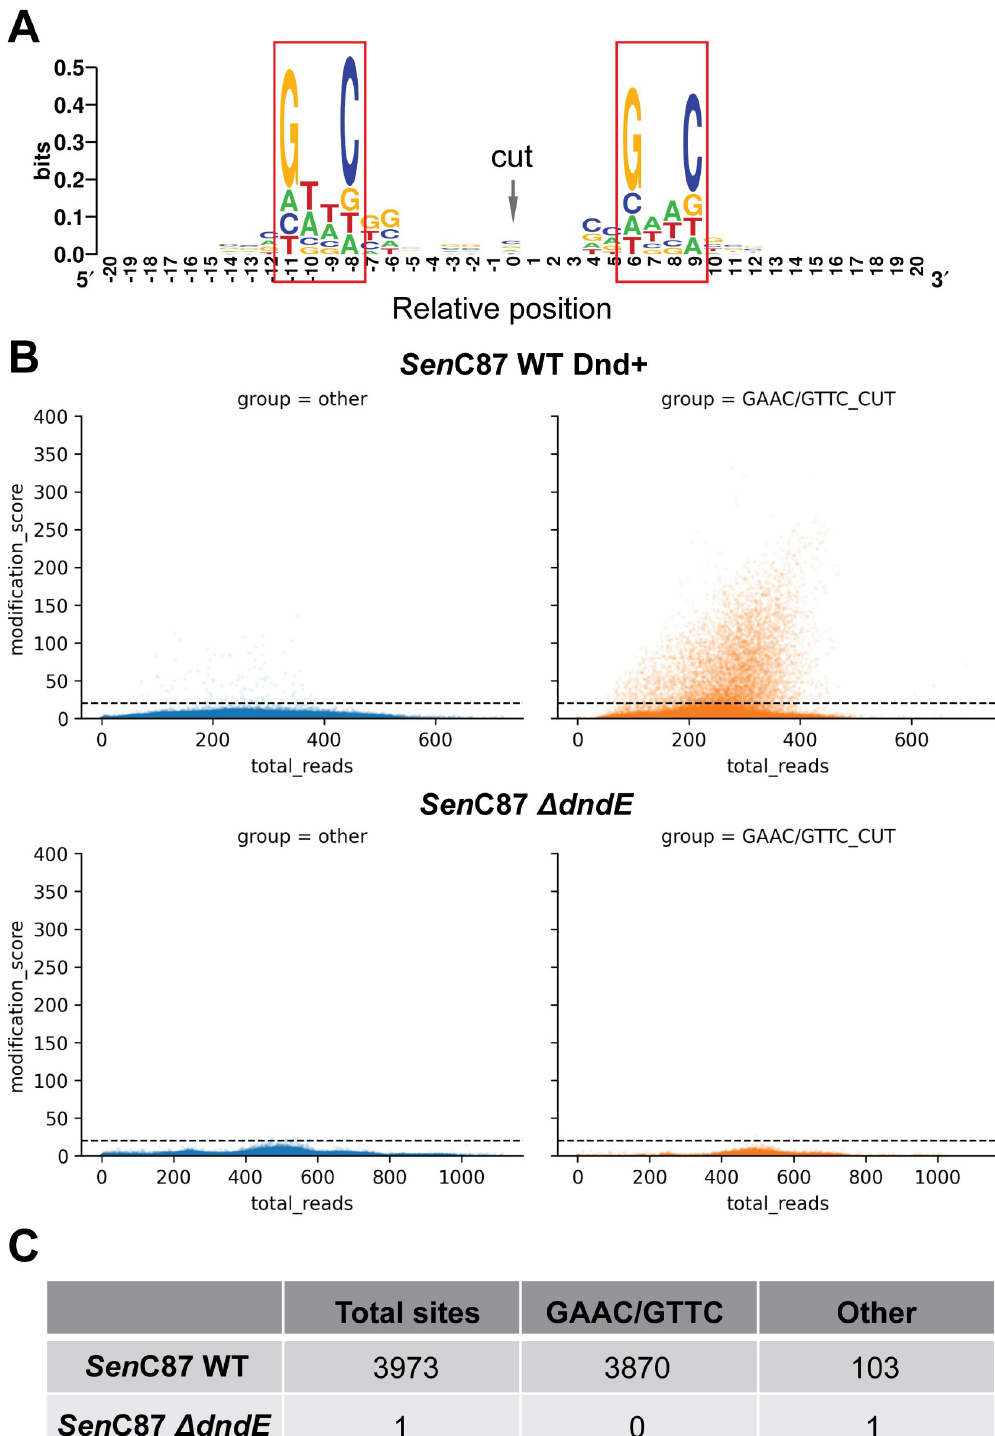
Fig 2. Genomic mapping of PT modification at single base resolution by EcoWI-seq. ( A ) Motif logo of positions with more than 50 5’ end reads in the genome of WT Dnd+ Sen C87 strain. ( B ) Plots of modification scores in the genome of WT Dnd+ (top) and Δ dndE mutant (bottom) strains. Dashed line showed the modification score cut-off used to call PT-modified sites. ( C ) Numbers of identified PT-modified sites by category.